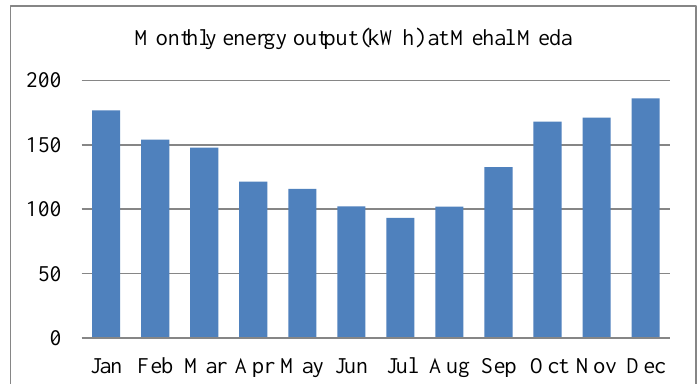
Figure 6. Energy assessment of solar system at Shewa Robit.